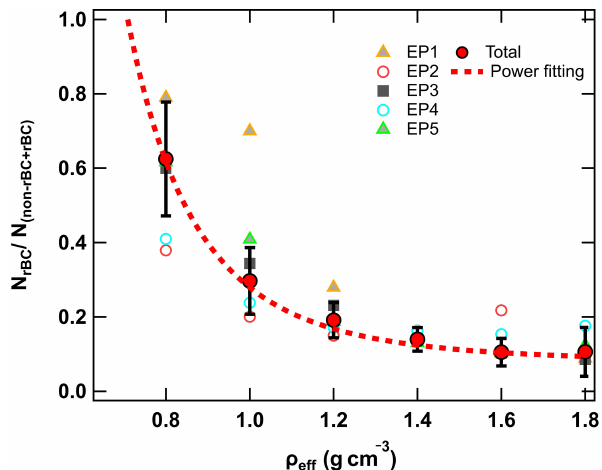
Figure 6. Number fractions of rBC-containing particles in the to- tal particles (rBC-containing and non-rBC particles) under different effective